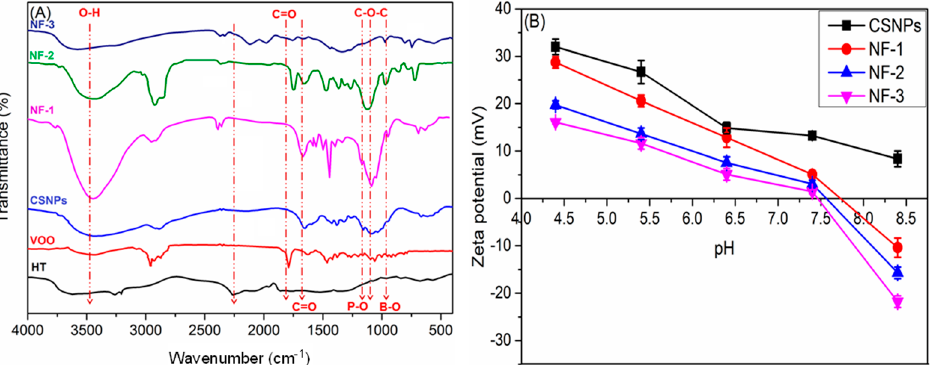
Figure 1. ( A ) FTIR spectra of the native VOO, HT, CSNPs, PBA ‒ CSNPs (NF ‒ 1), PBA ‒ CSNPs ‒ VOO (NF ‒ 2), and PBA ‒ CSNPs ‒ HT (NF ‒ 3). ( B ) Effect of pH on the value of ZP of CSNPs, NF ‒ 1, NF ‒ 2, and NF ‒ 3.